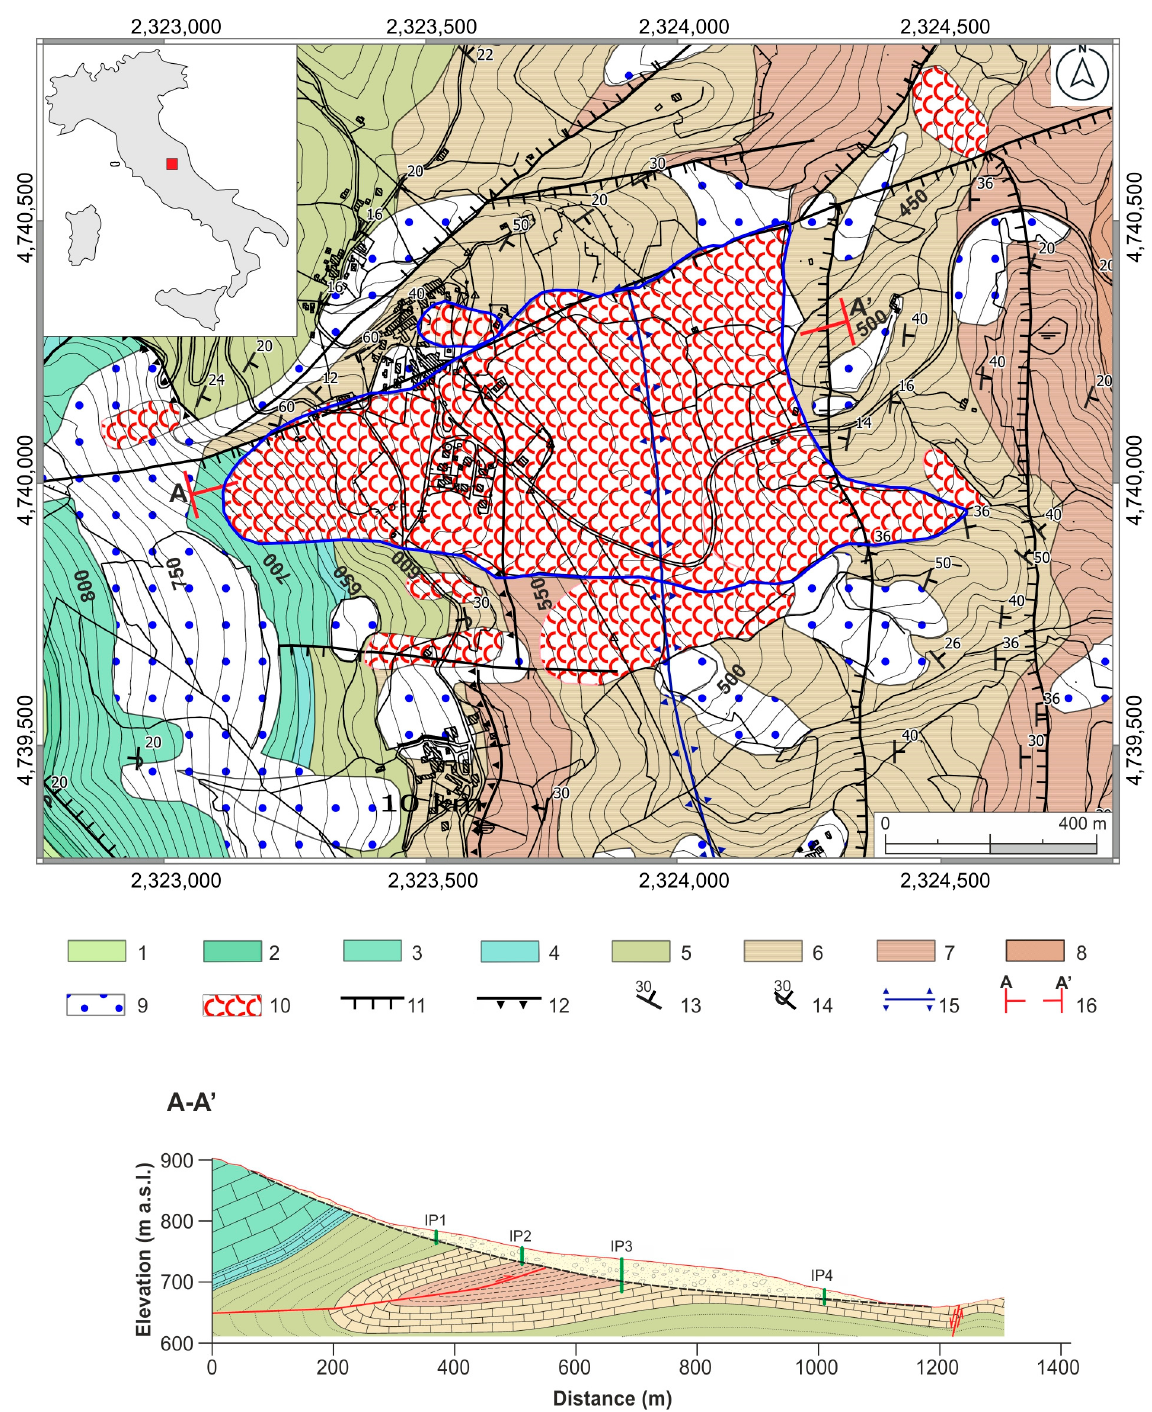
Figure 1. Geological map of the Montemartano landslide area, based on the geopackage of Umbria Region (https://www.onegis.it/2019/06/19/cartografia-geologica-umbria-stilizzata-per-qgis/, accessed on 10 January 2023), with an NE–SW geological cross section. (1) Marne a